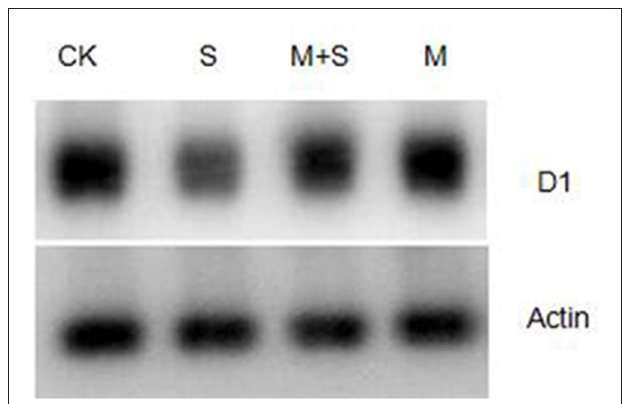
FIGURE 5 | Immunoblot analyses of D1 protein abundance in tomato leaves. Leaf extracts from different salt /melatonin treatments after 12 days. Immunoblot analysis of D1 protein using polyclonal antibody (Agrisera, Sweden) and secondary antibody (anti-rabbit IgG horse radish peroxidase conjugated, Agrisera, Sweden). Immunoblotting of actin (ACT, 45 kDa bottom) served as loading controls. CK, control; M, 150 µ M melatonin; S, 150 mM NaCl; M + S, 150 µ M melatonin with 150 mM NaCl.